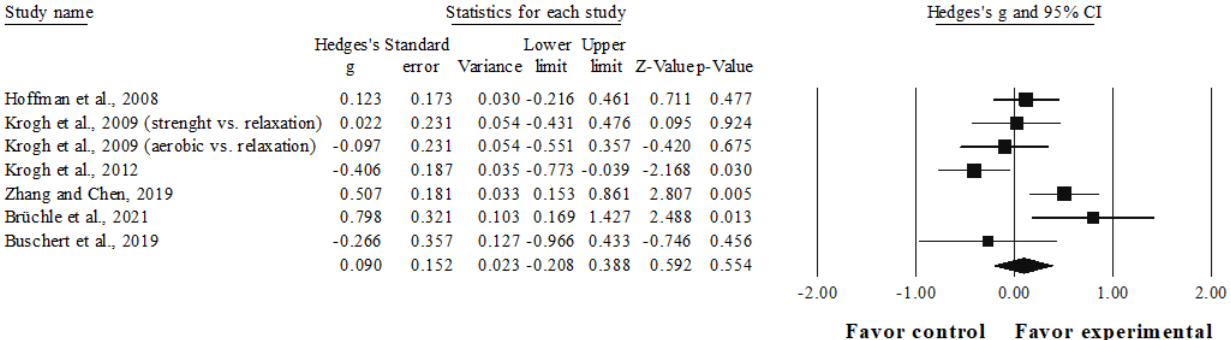
Figure 4. Forest plot for cognitive flexibility outcome. Values shown are effect sizes (Hedges’s g) with 95% confidence intervals. The size of the plotted squares reflects the statistical weight of the study. Black squares: individual studies. Black rhomboid: summary result.